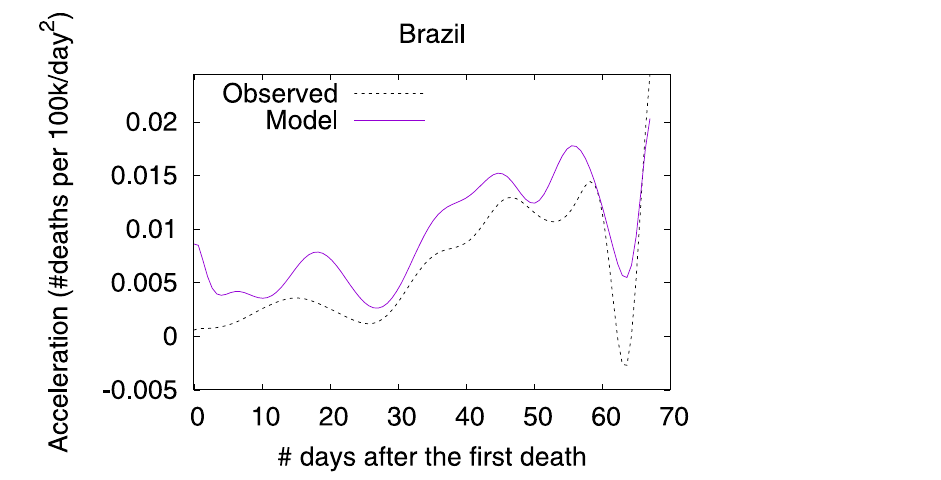
Fig 27. (Color online) projections for acceleration in Brazil.